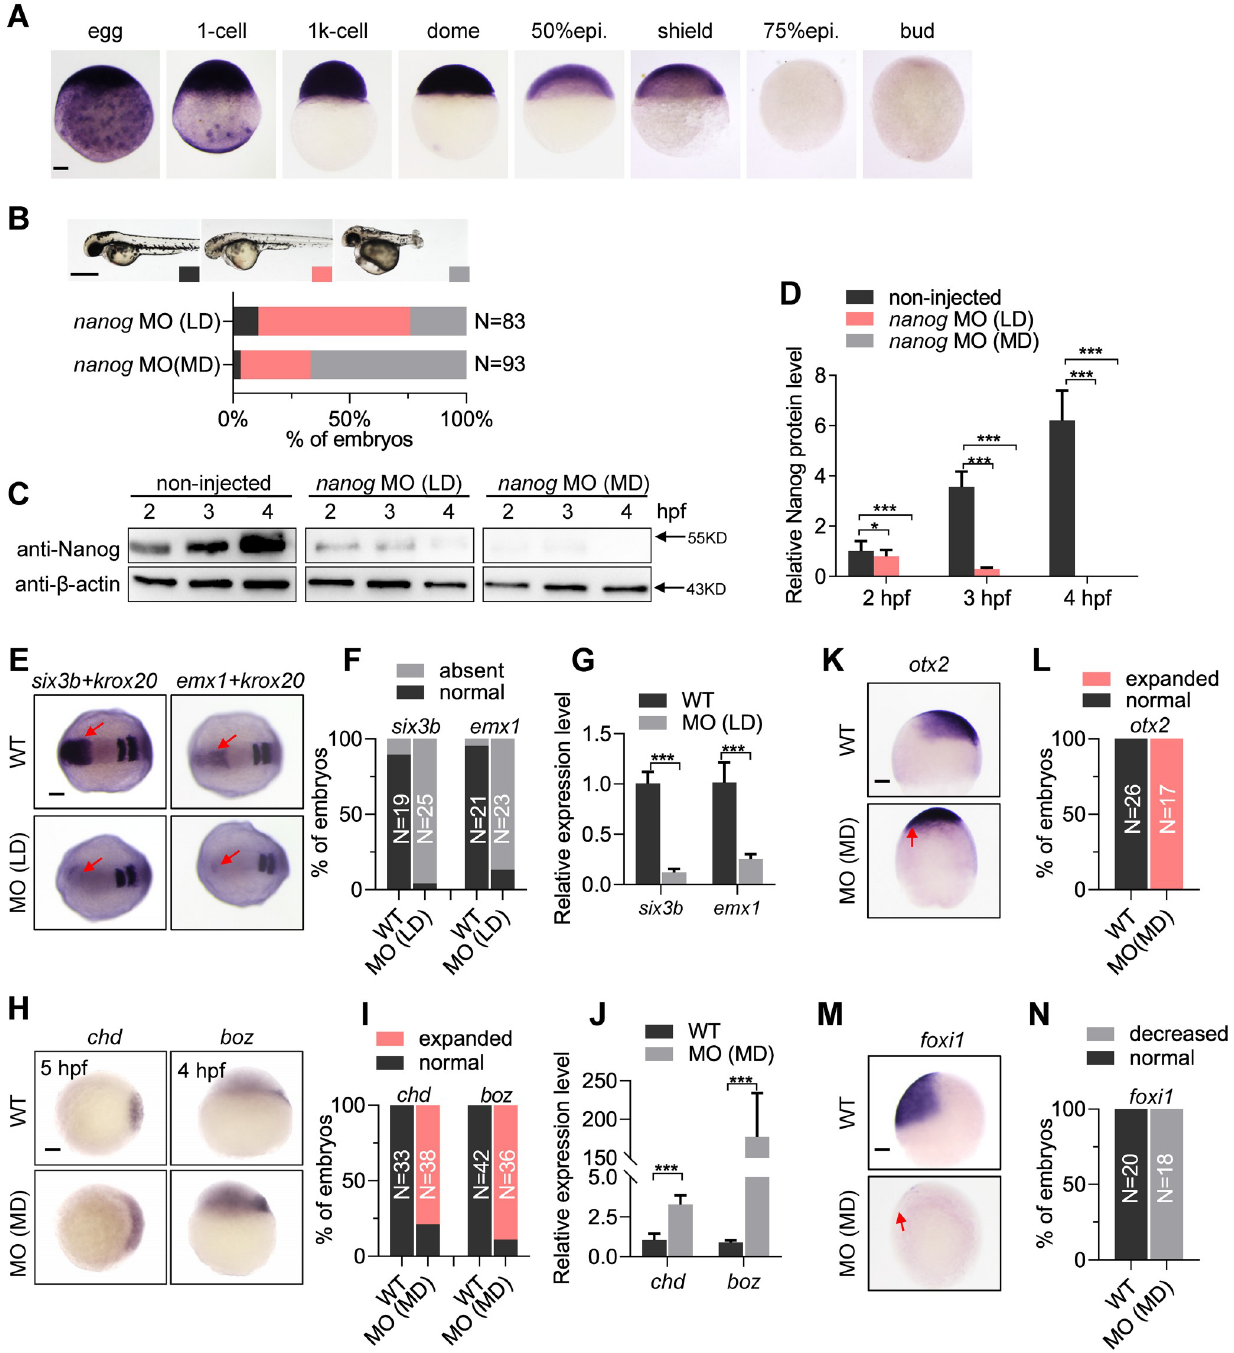
Fig 2. Knockdown of nanog leads to dorsalization and posteriorization. (A) WISH analysis showing nanog mRNA is maternally transcribed and vanishes at 75% epiboly stage. Scale bar, 100 μ m. (B) Two different phenotypes are observed at 2 doses (0.5 ng/embryo, LD; 1.2 ng/embryo, MD) of nanog MO injected embryos, forebrain defect and dorsalization. Phenotype was observed at 36 hpf. N represents analyzed embryo number. Scale bar, 500 μ m. (C) Western blot detection of Nanog in LD and MD nanog MO injected embryos. Nanog translation was blocked in all detected stages in the MD nanog MO injected embryos, and a low amount of Nanog protein can be detected at early stage in the LD nanog MO injected embryos. (D) Relative Nanog signal intensities in the western blot experiment (panel C). (E) WISH analysis showing expression of forebrain marker six3b and telencephalon marker emx1 were absent in LD MO injected embryos. krox20 was used as a stage-control marker. Red arrows indicate the expression region of six3b or emx1 . Scale bar, 100 μ m. (F) Statistical analysis of the embryos in panel E. N represents analyzed embryo number. (G) RT-qPCR analysis of six3b and emx1 in nanog morphants and WT embryos. Error bars, mean ± SD, ��� P < 0.001. (H) WISH analysis showing 2 maternal β -catenin targets, boz and chd , were up-